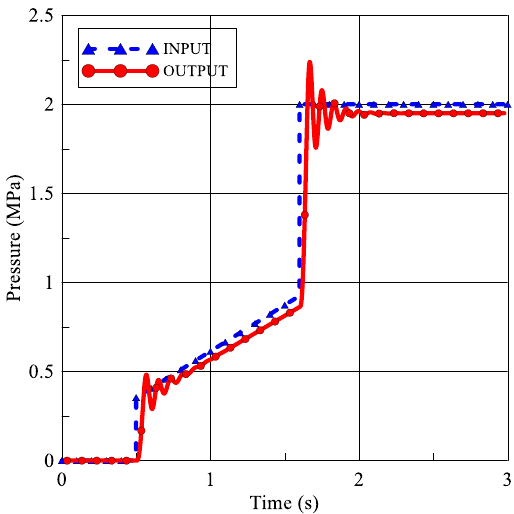
Figure 6. The 2D digital buffer valve cushioning characteristic curve.